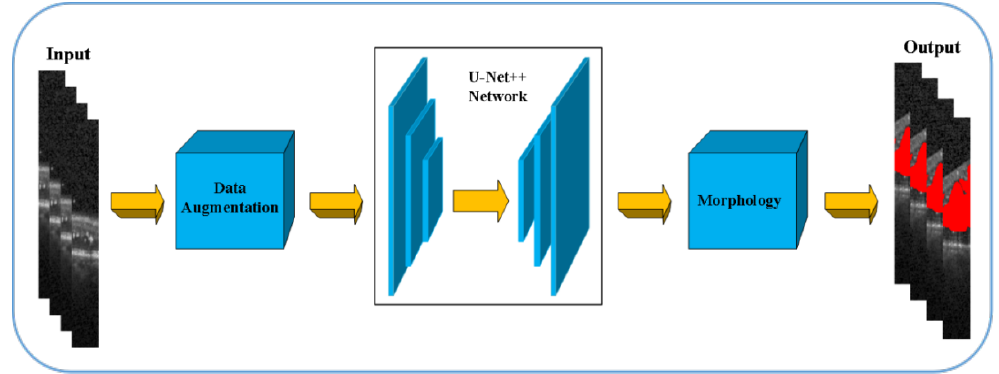
Figure 2. The flow chart of the proposed method.